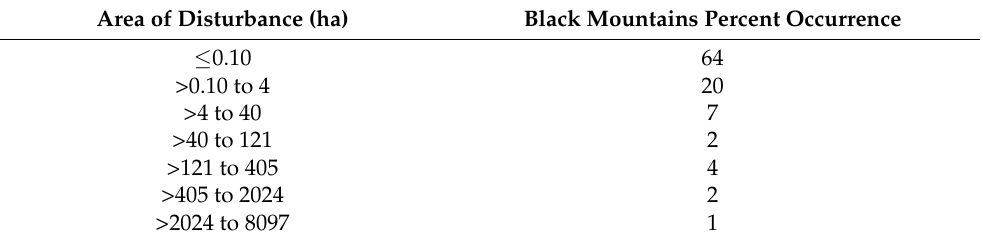
Table 2. Size distribution (ha) of fire events for the Black Mountains (UT) based on federal fire occurrence data from 1980 to 2016 and the Monitoring Trends in Burn Severity (MTBS) data from 1984 to 2016. For example, a size class of “ ≤ 4” indicates fire events were ≤ 4 ha. Area of Disturbance (ha)